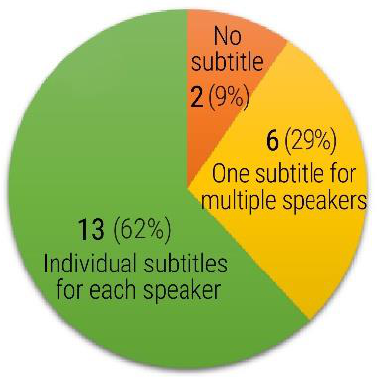
Figure 20. Preference on integrated or individual subtitles for multiple speakers.